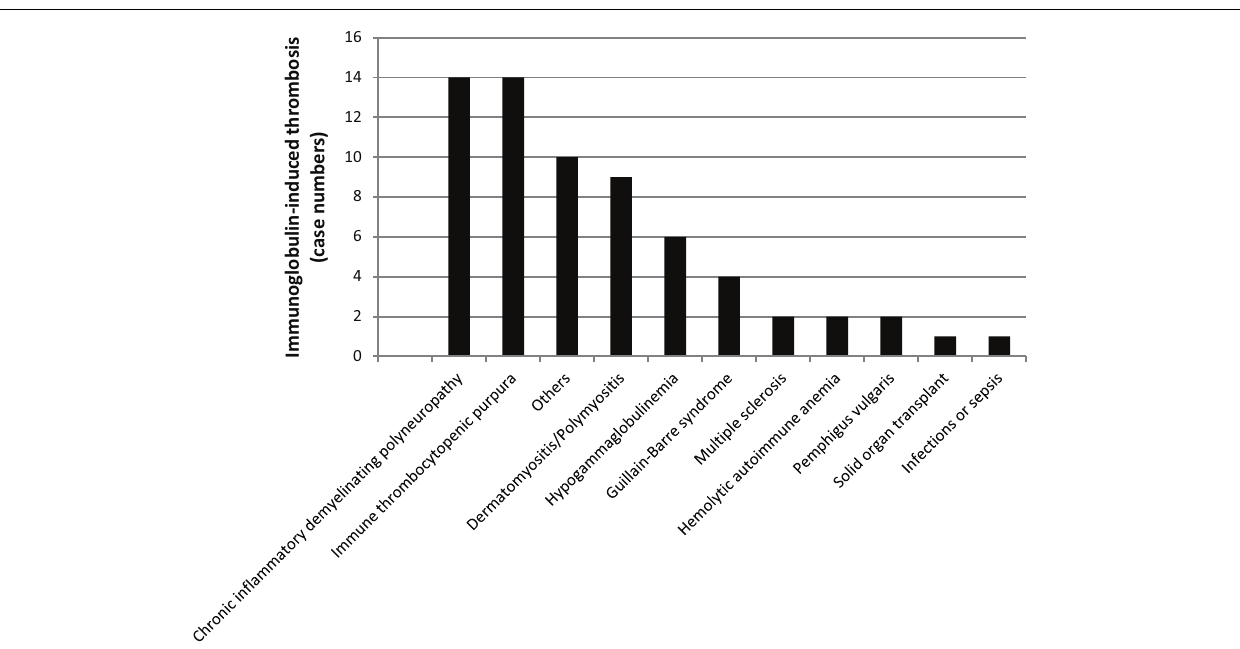
FIGURE 8 | Falling into a dark lunar crater while being on Ig treatment . Bars indicate the number of patients with a given clinical condition and Ig-mediated thrombosis.